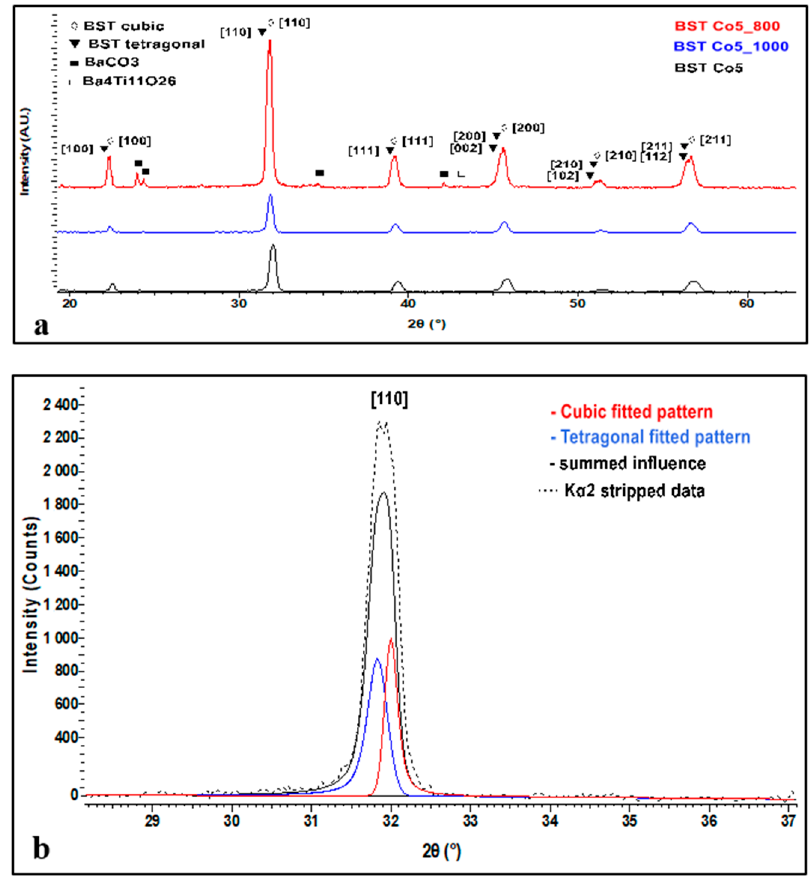
Figure 3. XRD analysis of BSTCo5, BSTCo5 _800, and BSTCo5_1000 ( a ), details of the cubic-tetragonal structure ( b ).